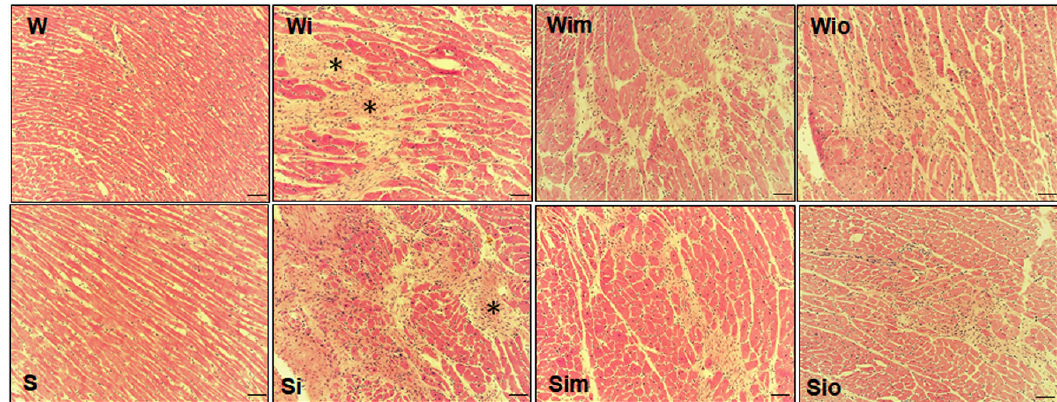
Figure 3. Diffuse ISO-induced myocardial injury characterized by necrotic and atrophied cardiomyocytes (asterisks) as well as by infiltration with basophils in Wistar rats (Wi) and Spontaneously hypertensive rats (Si) comparing to controls (W, S). Note reduced foci of injury after treatment of ISO exposed rats to melatonin (Wim, Sim) or omega-3 (Wio, Sio). Haematoxylin-eosin staining, bar 200 µm.